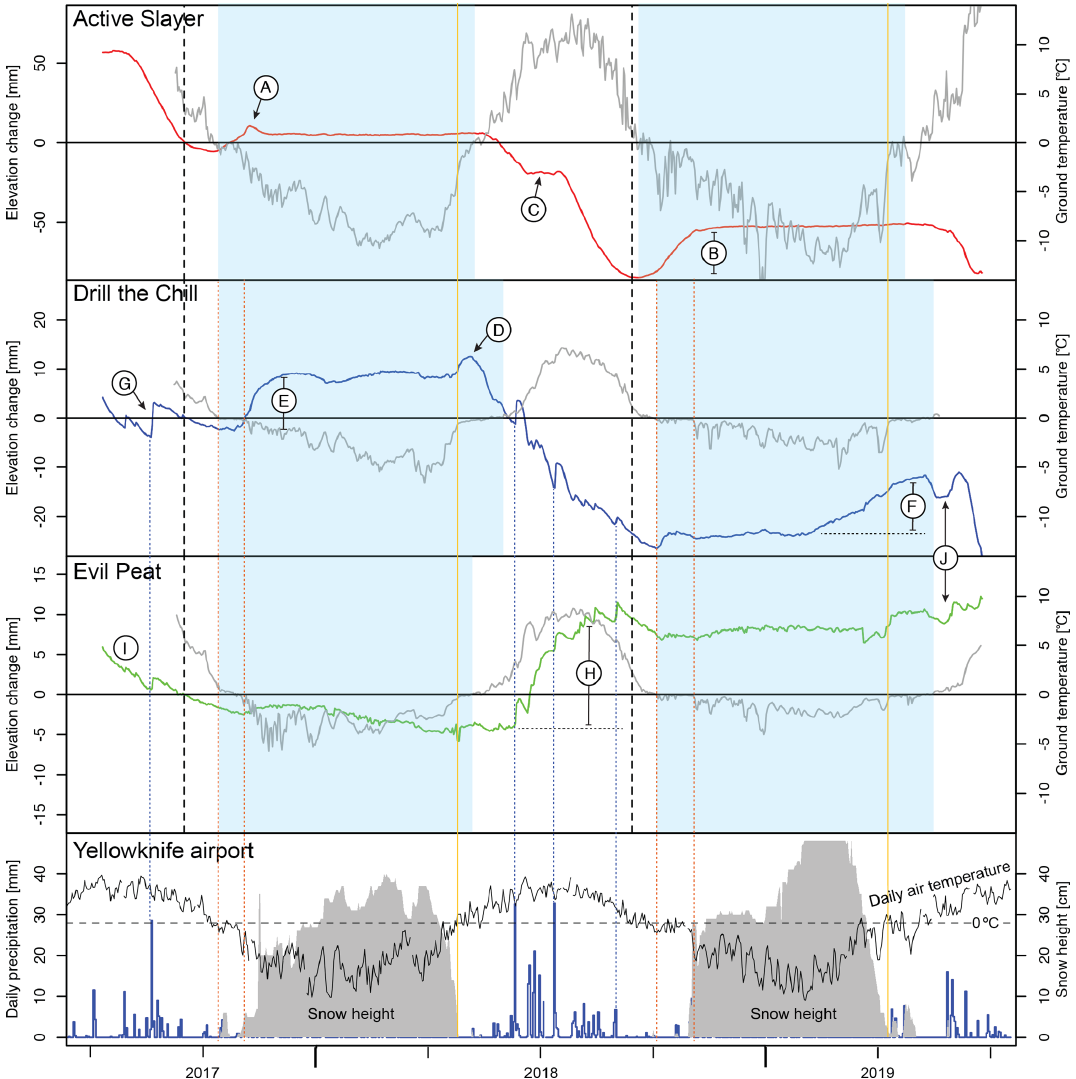
Figure 6. Daily elevation change and ground temperature (0.30–0.35mm) recorded at the three sites, with nearby ( < 25km) precipitation (blue steps) and snow height (grey polygons). Air temperature (black) is shown relative to 0 ◦ C (dashed) for context and without scale. Blue shading indicates approximate period of soil freezing; orange vertical lines indicate the approximate timing of snowpack ripening and meltwater input into the ground; and vertical dashed lines indicate 1 full measurement year (black), selected precipitation events (blue), and the approximate duration of the autumn zero-curtain periods at Drill the Chill and Evil Peat (red). Letters in circles identify events discussed in the main